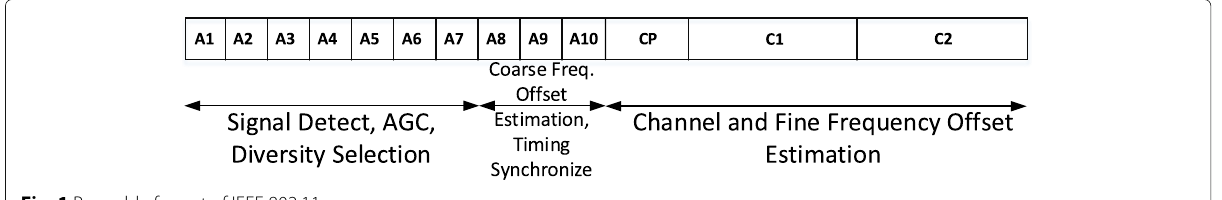
Narthil can achieve a nearly 100% and 80% of packet delivery ratio on WiFi and ZigBee, respectively.